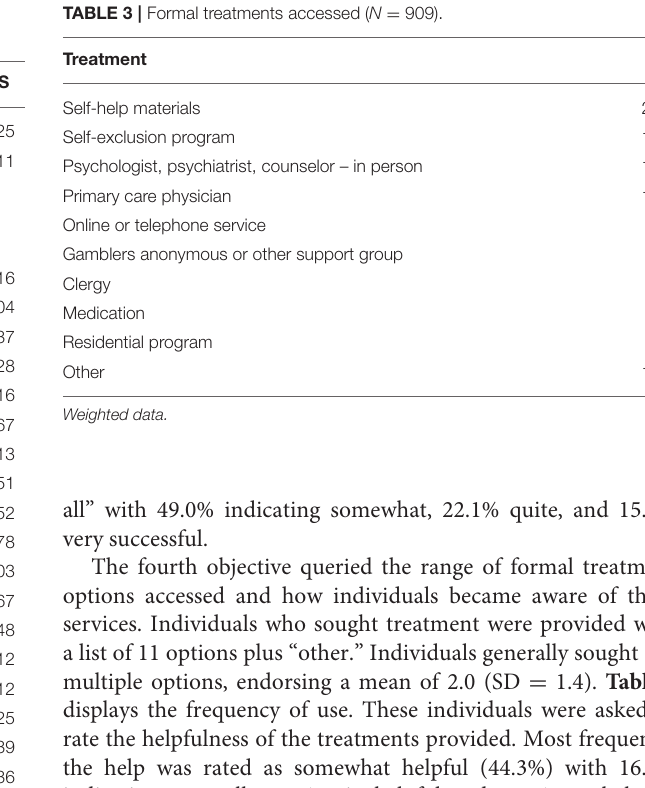
TABLE 3 | Formal treatments accessed ( N =